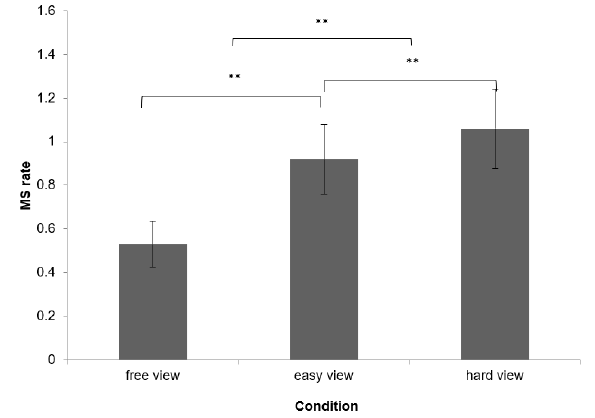
Figure 5: Microsaccade rate was significant higher in the hard view condition than in the easy view or free view condition.